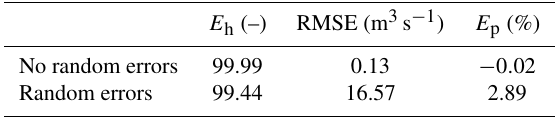
Table 4. Secchia River: Nash–Sutcliffe E h , root-mean-square error (RMSE), and error in the peak discharge E p